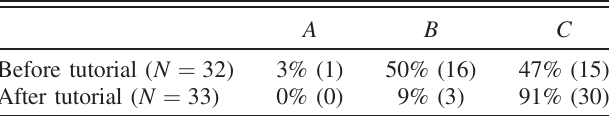
TABLE IV. Responses to question 2 (Fig. 2) given immediately before and after the tutorial.